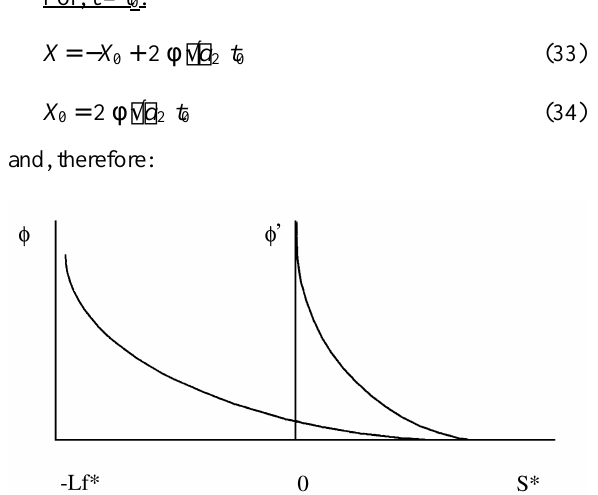
Figure 2. Schematic representation of the variation of f and f ‘, as a function of S*, for a given metal-mold system. Their behavior is different because they are described by different mathematical expressions.